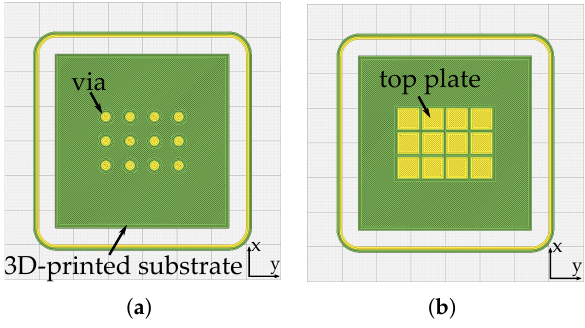
Figure 13. Top view of CURA print preview. ( a ) Middle layer. ( b ) Top layer.